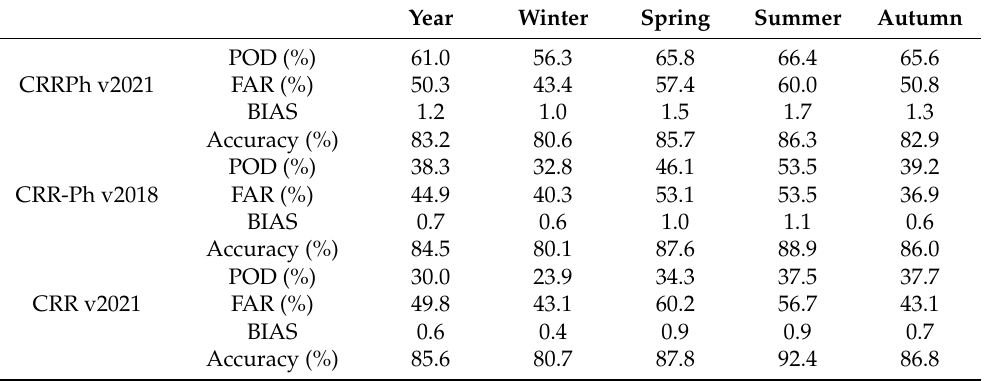
Table 2. Twenty-four-hour categorical statistics for CRRPh v2021, CRR-Ph v2018, and CRR